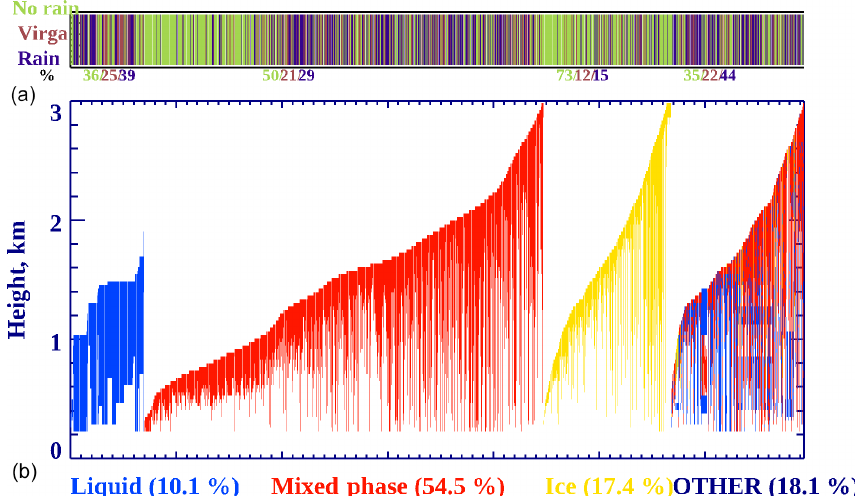
Figure 7. (a) The drizzling status for each categorized cloud type, e.g., no rain (green), virga (brown), and rain (navy blue). The percentages shown below the x axis represent the portion of drizzling in each type of cloud. (b) The percentages and vertical distributions of classified liquid, mixed-phase, ice, and other clouds for each column in the single-layered, low-level clouds, represented by different colors, over the entire domain during MARCUS. Each line represents one 5min sample. The definition of drizzle here is the radar reflectivity below the ceilometer-derived cloud base, which could be either liquid drizzle drops or ice crystals.